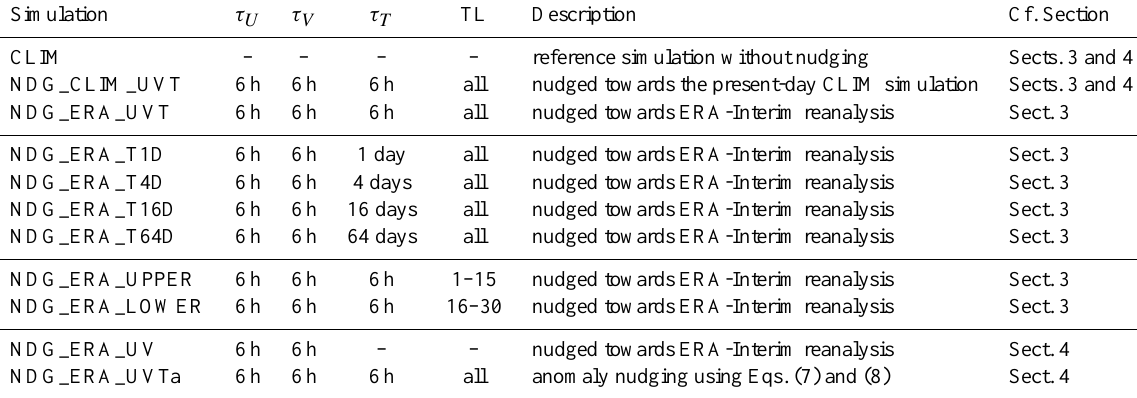
Table 1. List of CAM5 simulations. τ U , τ V , τ T are the relaxation time scales for zonal wind, meridional wind, and temperature, respectively. TL refers to the vertical levels (given as indices counting from model top) on which temperature nudging was applied. The interface between model layers 15 and 16 roughly corresponds to the 300hPa pressure level. Details of the experimental setup are described in Sect. 2.3.